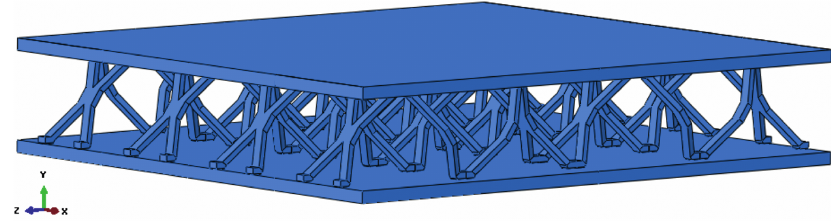
Figure 1: Schematic of the X-type lattice truss sandwich panel structure.